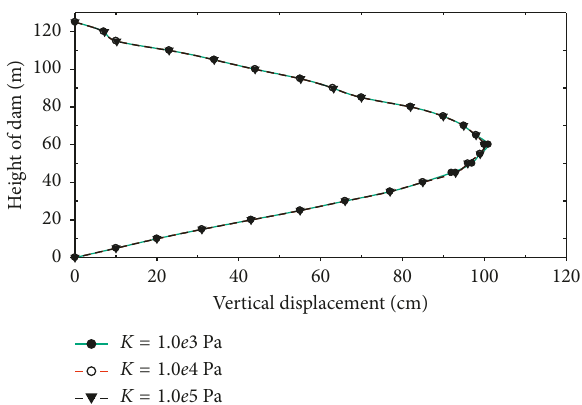
Figure 10: Comparing the displacement values in the middle of the core for different bulk modulus of water in the water-flow stage.